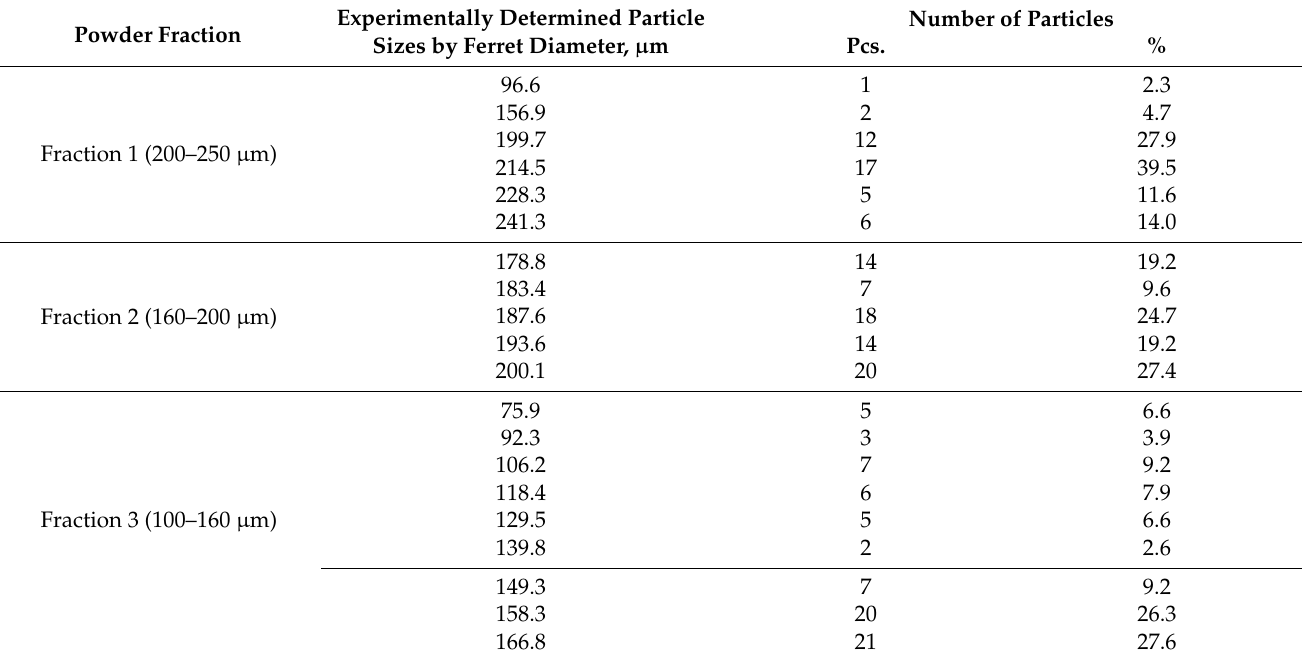
Table 1. Experimental distribution of titanium alloy powder particle sizes with polyhedral shapes.